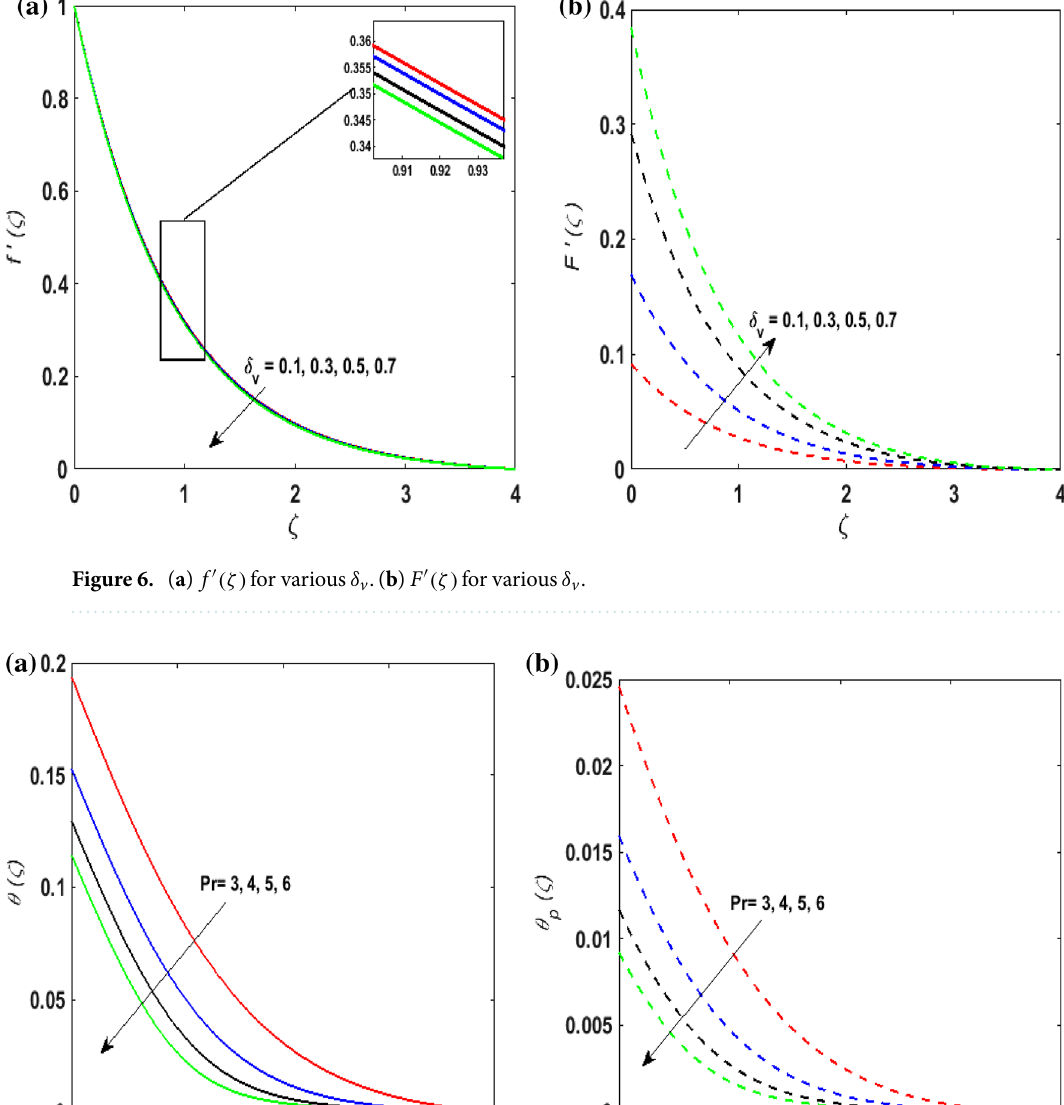
boundary layer and θ(ζ) and θ p (ζ) decreases. In Fig. 8a,b, the outcome of the features of N t on θ(ζ) and θ p (ζ) is depicted. On amplifying N t , the temperature of the fluid far away from the surface upsurges. Therefore, θ(ζ) and θ p (ζ) augments. Figure 9a,b portrays the outcome of thermal relaxation time K 1 on θ(ζ) and θ p (ζ) . As the relaxation parameter is enhanced an additional time is required it for the transmission of energy from the heated surface to the fluid. Thus, the thermal relaxation parameter assesses the time for the transmission of heat. Therefore, escalating values of K 1 deteriorates θ(ζ) and θ p (ζ) . To visualize the impact of the conjugate heat param-